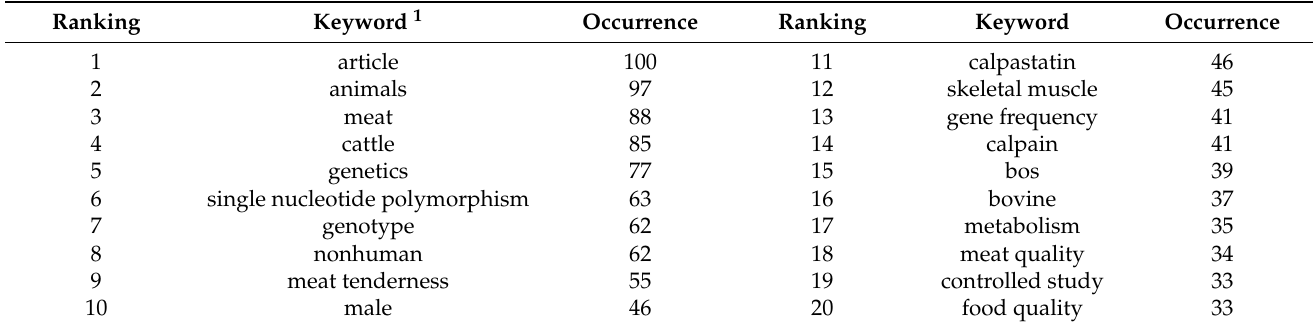
Table 6. Keywords with the highest occurrence in the papers.